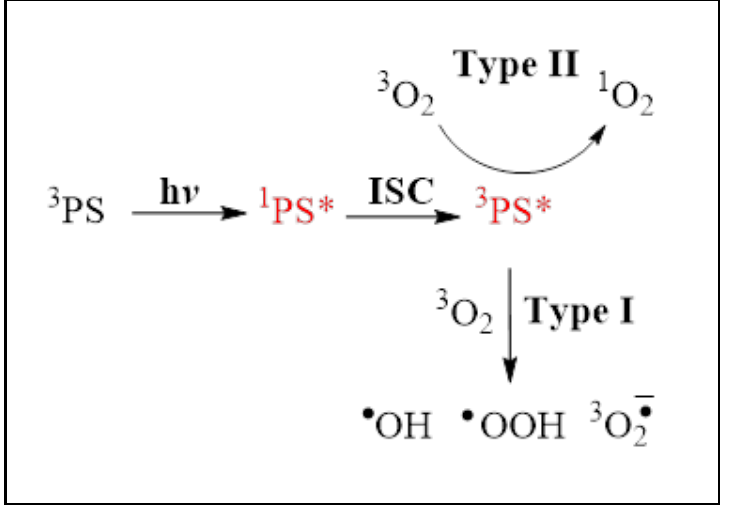
Figure 1. Mechanism of photodynamic ROS generation. As a result of the absorption of light (hv) by the ground state